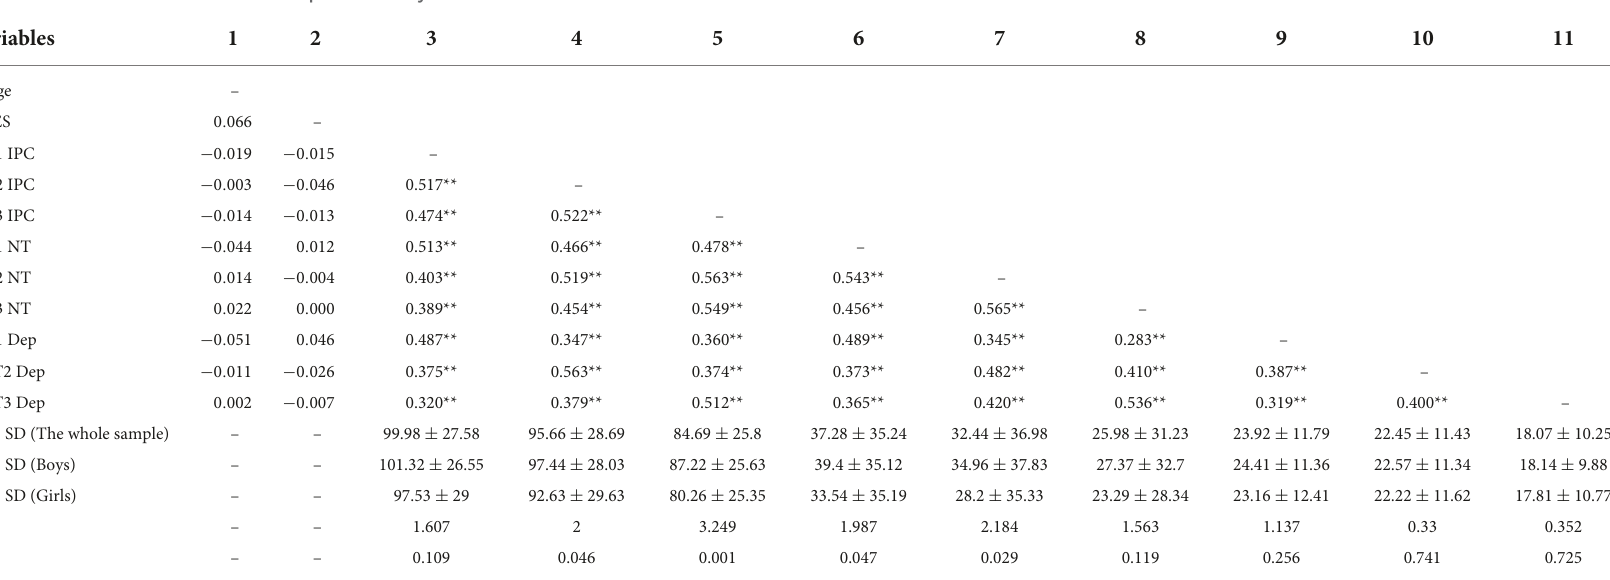
TABLE 1 Bivariate correlations and descriptive for study